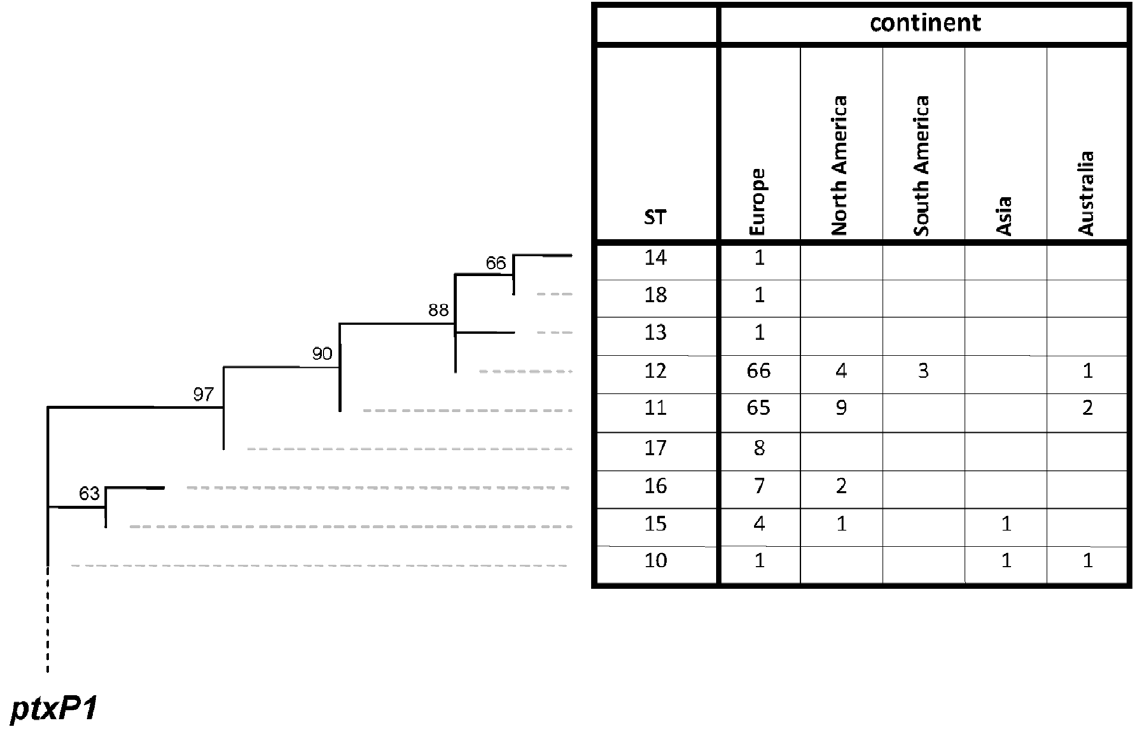
Figure 5. Maximum Parsimony tree of 179 ptxP3 strains found worldwide based on 87 SNPs. See legends to Fig. 1 for further details.